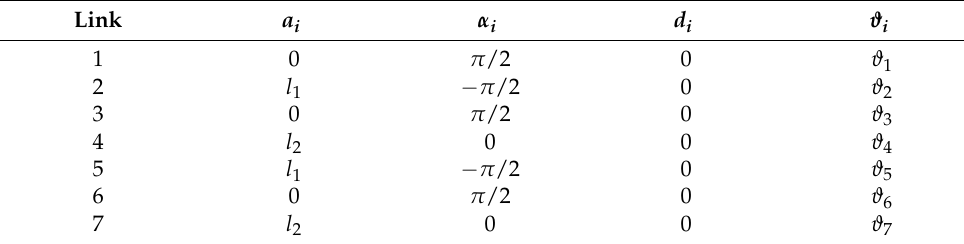
Figure 4. Kinematic scheme with additional degrees of freedom. Table 2. Flexible Robot Denavit-Hartenberg